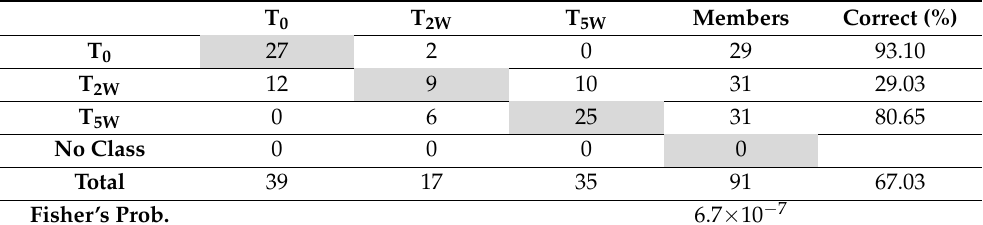
Table 2. Misclassification table of the EBC samples from COPD patients under PR according to the OPLS-DA model of Figure 2. The gray diagonal highlights the T 0 , T 2W , and T 5W patients that are correctly classified: 27/31 at T 0 , 9/31 at T 2W , and 25/31 at T 5W , and the unclassified patients. T 0 T